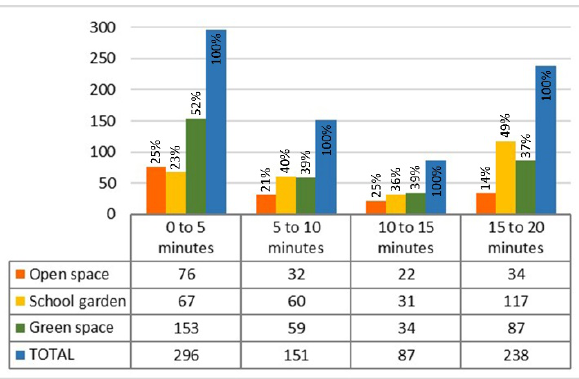
Figure 4: Walking time to shelter area